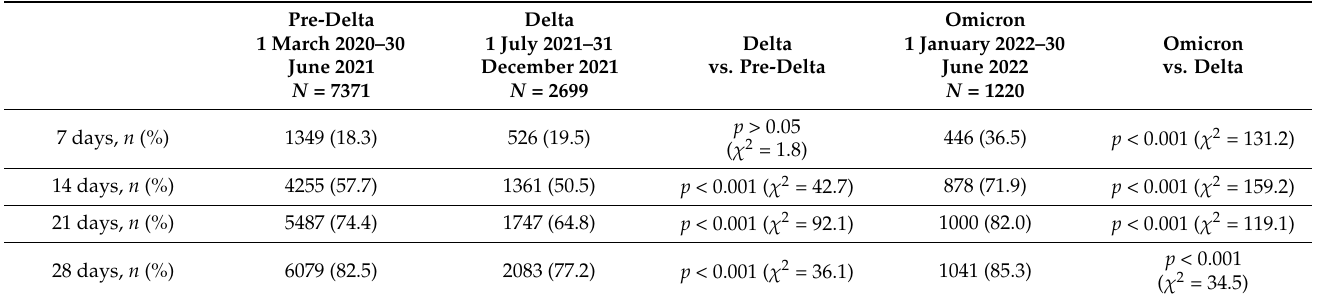
Figure 1. Ordinal scales after 7, 14, 21, and 28 days of hospitalization due to COVID-19 during periods with the dominance of particular SARS-CoV-2 variants. The scores were defined as follows: (1) not hospitalized, no activity restrictions; (2) not hospitalized, no activity restrictions and/or not requiring oxygen supplementation at home; (3) hospitalized, not requiring oxygen supplementation and not requiring medical care; (4) hospitalized, requiring no oxygen supplementation, but requiring medical care; (5) hospitalized, requiring normal oxygen supplementation; (6) hospitalized, requiring non-invasive ventilation with high-flow oxygen equipment; (7) hospitalized, for invasive mechanical ventilation or extracorporeal membrane oxygenation; (8) death. Table 3. Comparison of the frequency of discharge from hospitals during the 7, 14, 21, and 28 days of observation in the periods of dominance of particular variants.